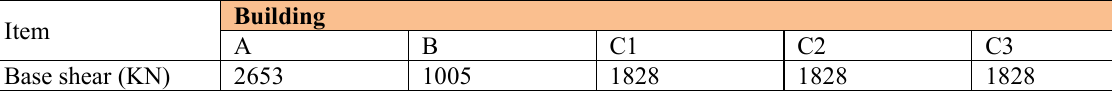
Fig. 5. Story stiffness considering earthquake load (Ex). Base shear of the building.